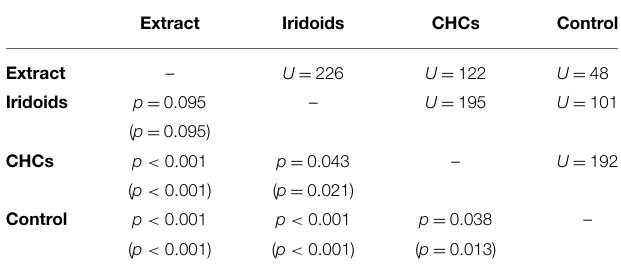
TABLE 4 | Statistical details for the pairwise comparisons of courtship duration toward extract, fractions, and control for L. heterotoma .